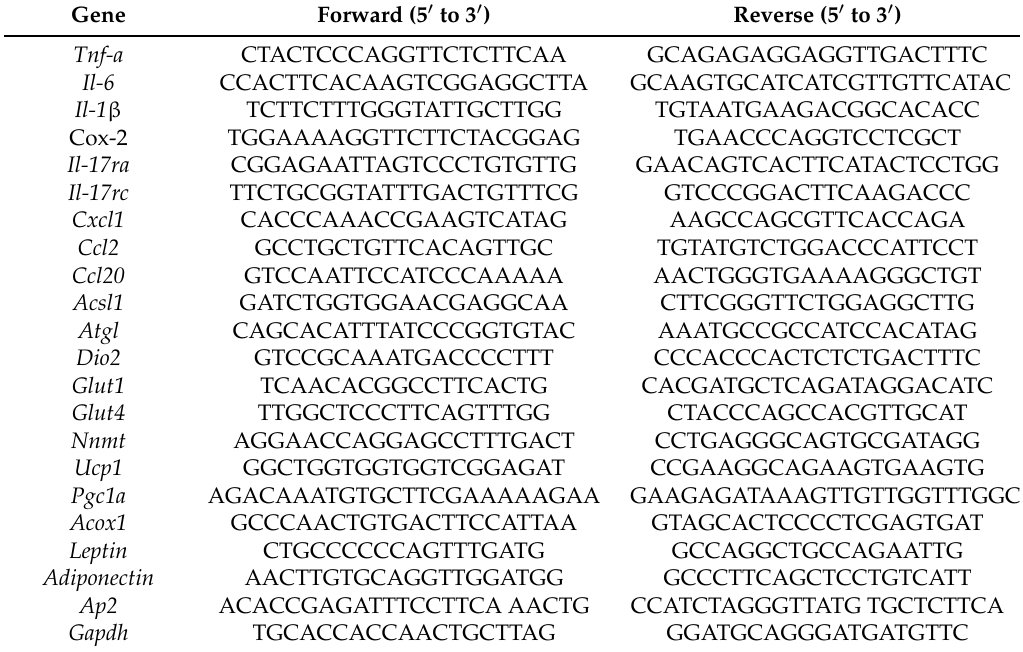
Table 3. PCR primer